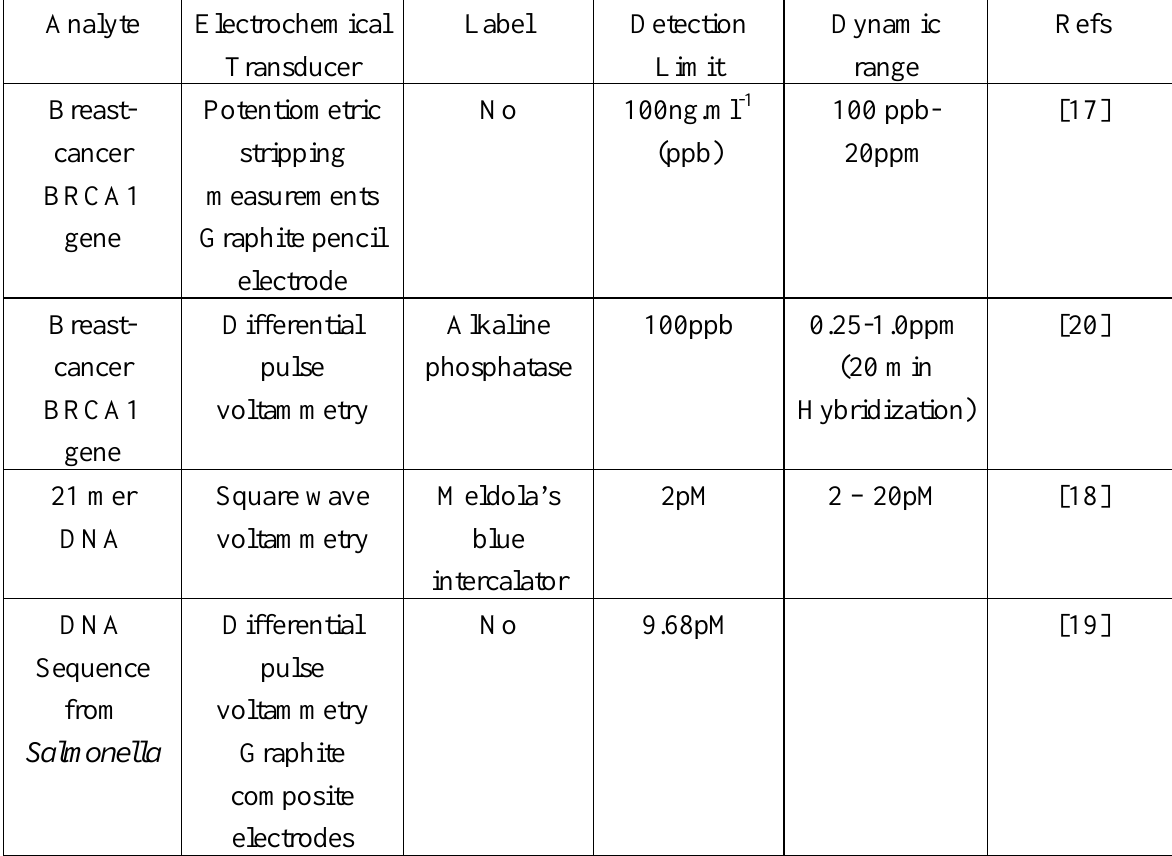
Table 3. Features of the different genomagnetic electrochemical